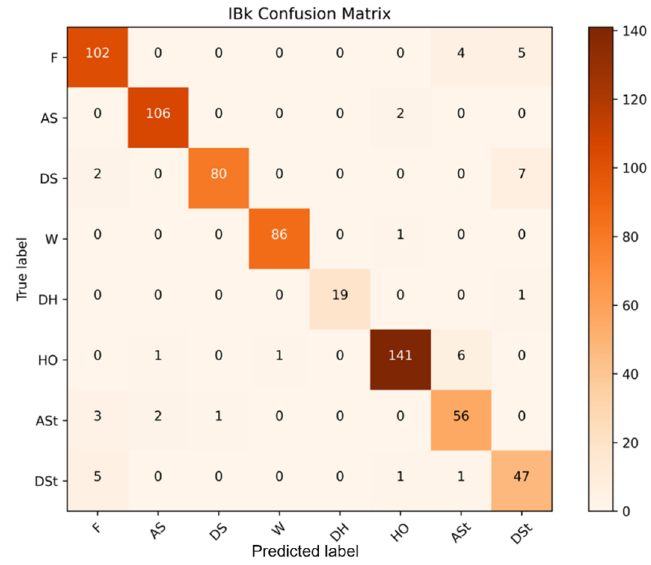
Figure 21. IBk Confusion Matrix Using DS2.